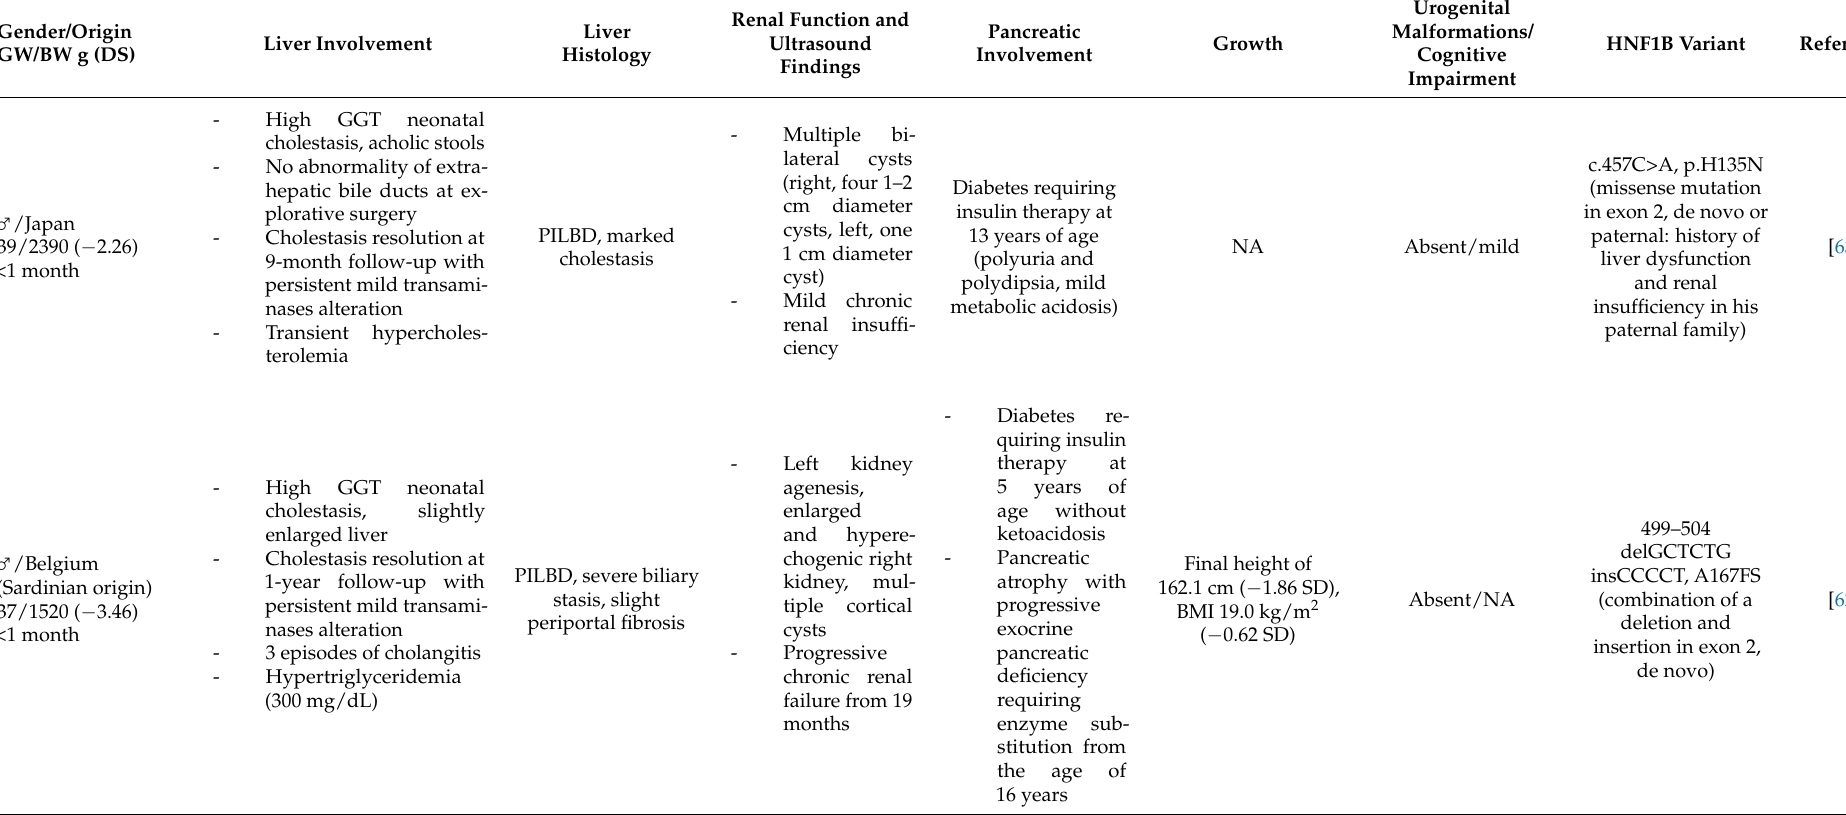
Table 2. Clinical and histopathological features of patients’ with HNF1B variants presenting with neonatal